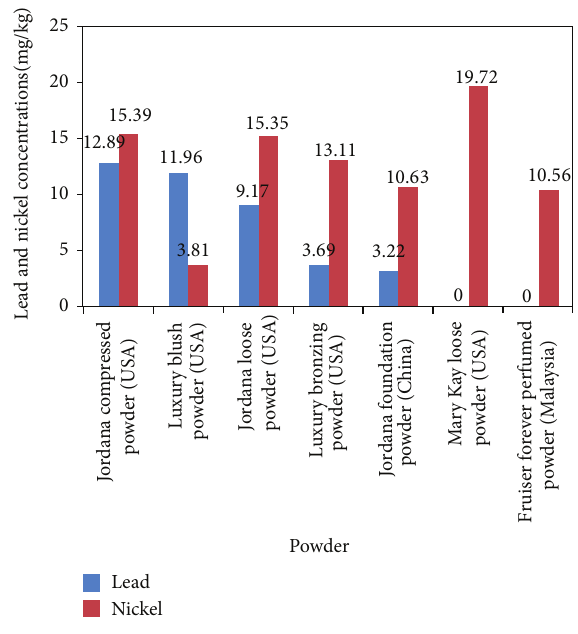
Figure 3: Lead and nickel concentrations in powders. Suggested safe levels of Gondal et al. (0.5 ppm), Expert Panel 2007 (0.2 ppm), Germany (1ppm). Suggested safe levels of nickel: Gondal et al. (5ppm), Basketter et al. low limit level (1ppm), andBasketter et al. high limit level (5ppm).